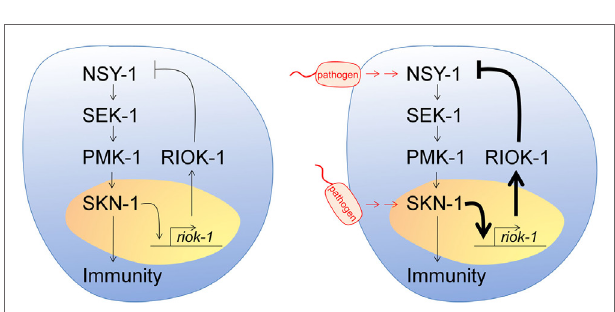
FigUre 7 | Model of a p38 MAPK, SKN-1, and RIOK-1 feedback loop upon infection in Caenorhabditis elegans . Pathogens activate the p38 MAPK pathway and increase the expression of riok-1 through the transcription of skn-1 . RIOK-1 has an important role in a feedback loop that regulates the expression of the p38 MAPK pathway in order to maintain immune homeostasis.